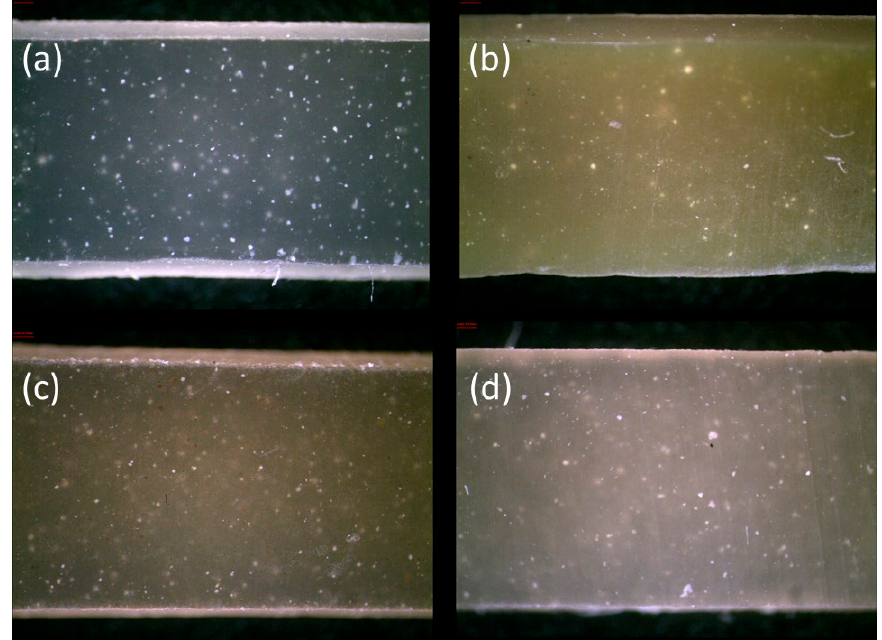
Figure 7. The microscopic photos revealing appearance of pure ENR/SIL composite and ENR/SIL material with natural phenolic compounds addition: pure ENR/silica sample ( a ), ENR/silica hybrid with quercetin ( b ), ENR/silica hybrid with tannic acid ( c ), ENR/silica hybrid with gallic acid ( d